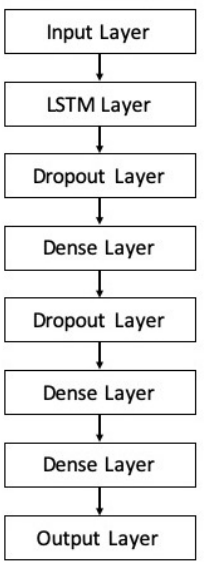
Figure 5. Proposed recurrent neural network